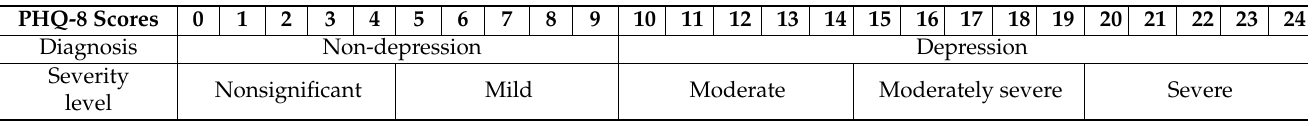
Table 1. Correspondence between PHQ-8 score and severity